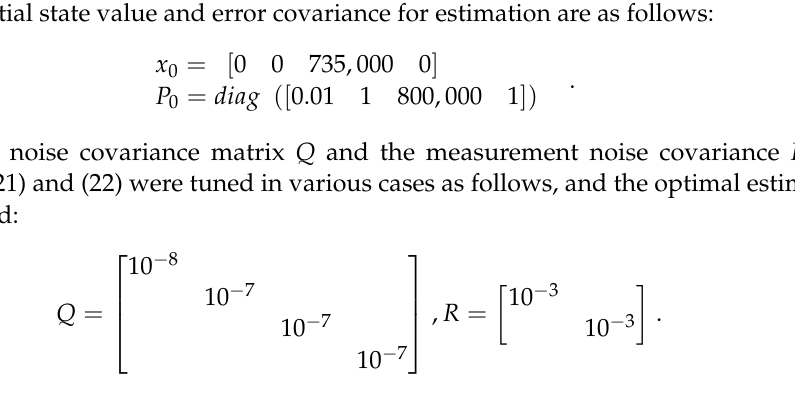
drop occurs, the AEKF can deal